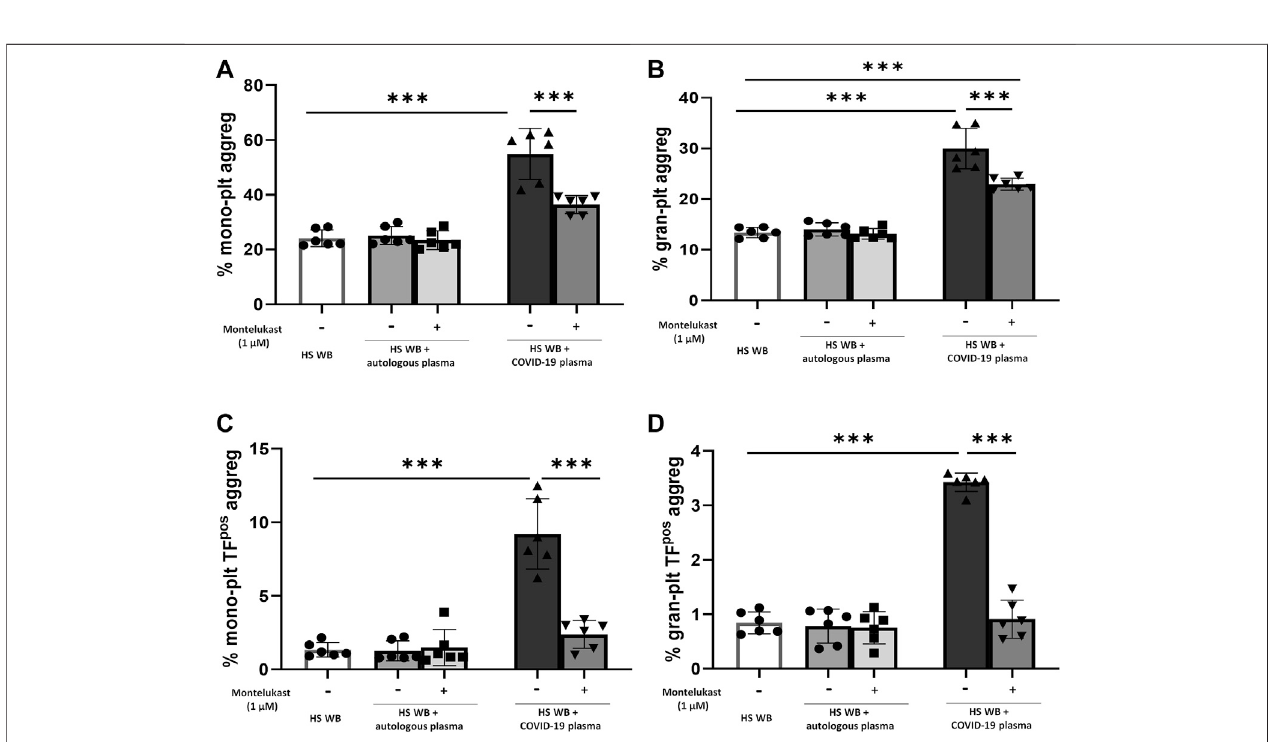
FIGURE 2 | In vitro effect of montelukast on platelet – leukocyte aggregate formation induced by COVID-19 plasma. Whole blood (WB) from healthy subjects (HS; n =6),pre-incubatedwithmontelukast(1 µM)asindicated,wasplasma-depleted andreconstitutedwithCOVID-19plasmapools(darkgraybars)orautologousplasma (light gray bars). Total (A,B) and TF pos (C,D) -platelet – leukocyte aggregates was measured by fl ow cytometry. Data are reported as mean ± SD. *** p < 0.001 (TF, tissue factor; plt, platelets; mono, monocytes; gran,